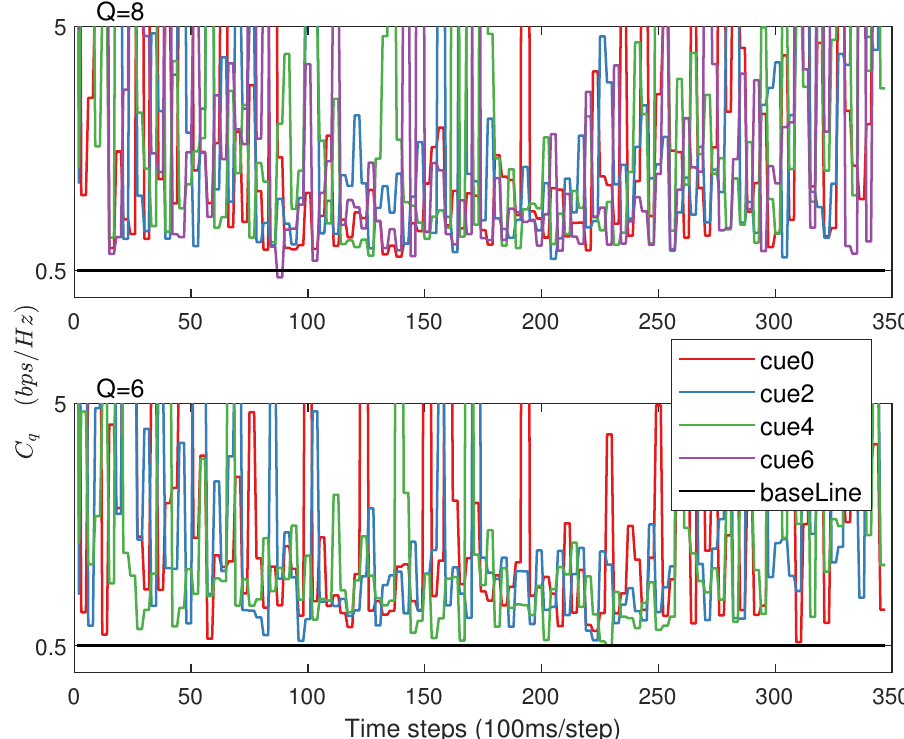
Figure 8. The ergodic capacities of CUEs when the resource allocation period is 300